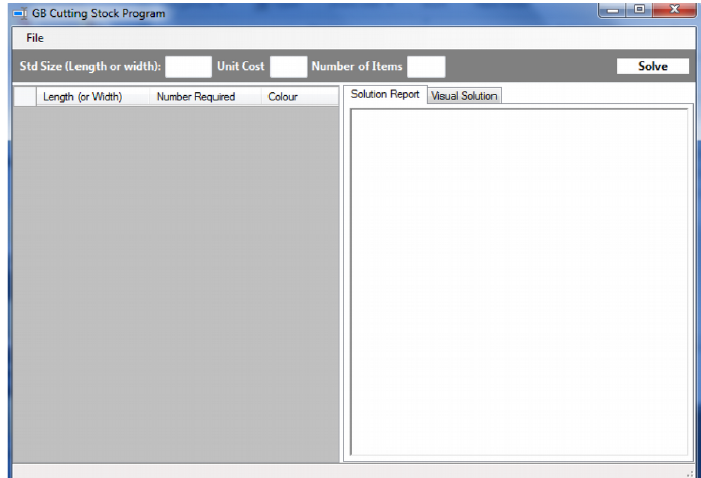
Figure 2. GB Cutting stock program